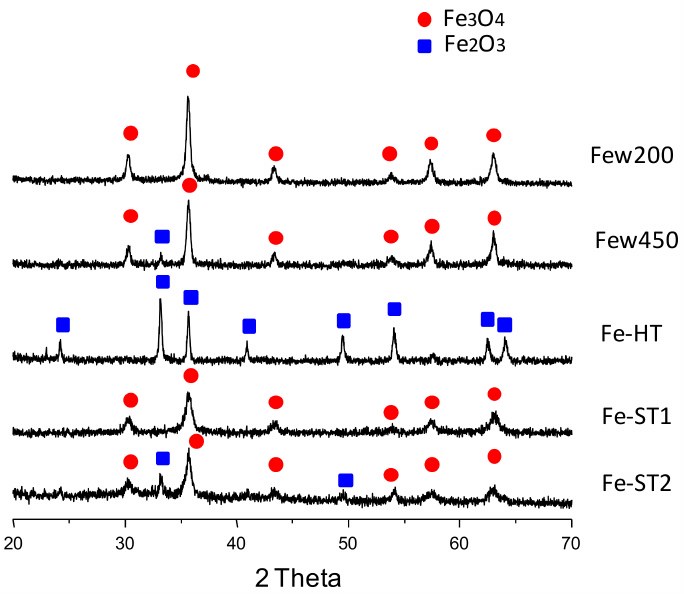
Figure 3. XRD patterns of the iron oxide catalysts synthesized. Crystalline phases: • Fe 3 O 4 (spinel-type magnetite, JCPDS: 19-629, or maghemite, JCPDS No.39-1346) and (cid:4) Fe 2 O 3 (JCPDS: 24-0072). Textural characteristics of the samples were analyzed by N 2 adsorption isotherm measurements.